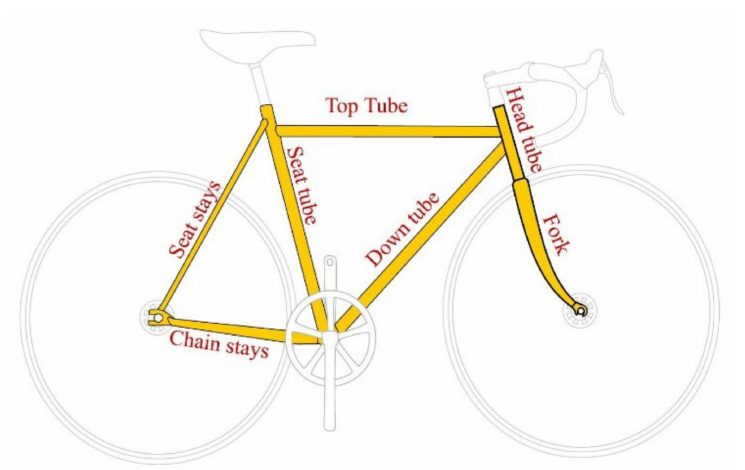
Figure 3. Basic tube diagram of a typical frame [30]. No changes were made to the original illustration (Keithonearth, CC BY